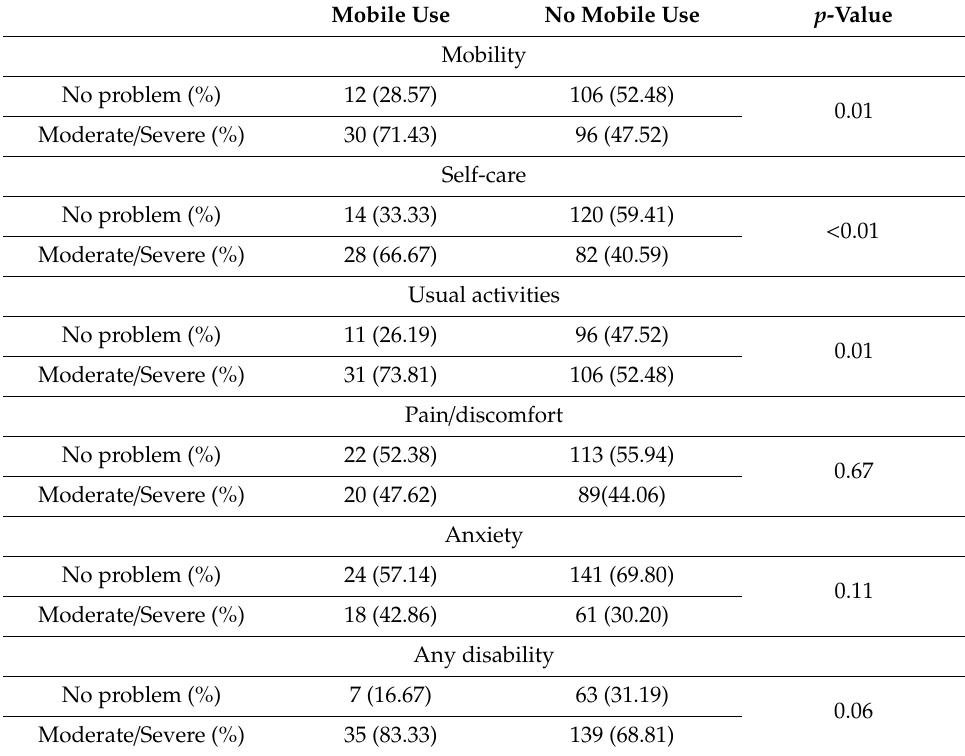
Table 2. Frequencies of the five European Quality of Life (EQ-5D) dimensions by mobile phone use while driving.